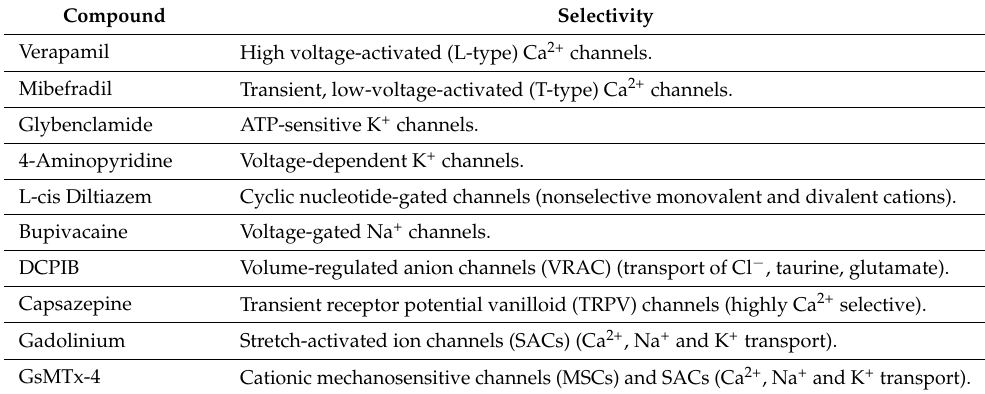
Table 2. List of the ion channel blockers tested on seabream sperm kinetic